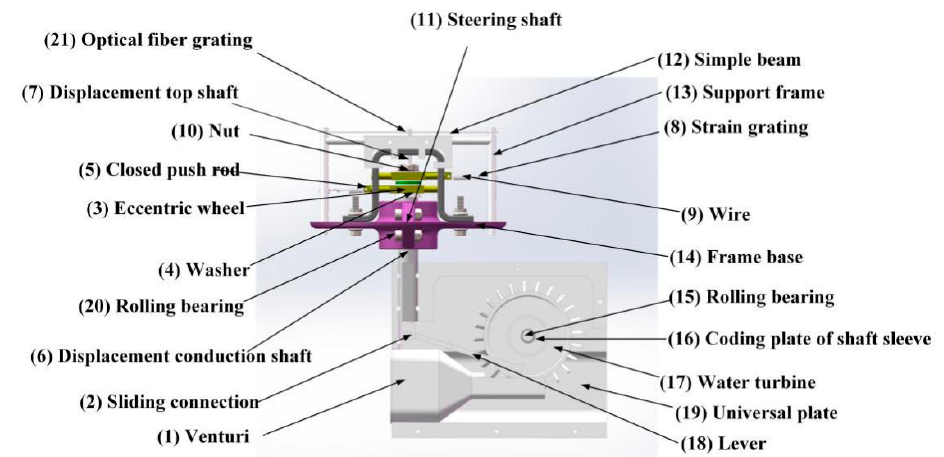
Figure 1. The structure of Flow Velocity and Direction Sensor.